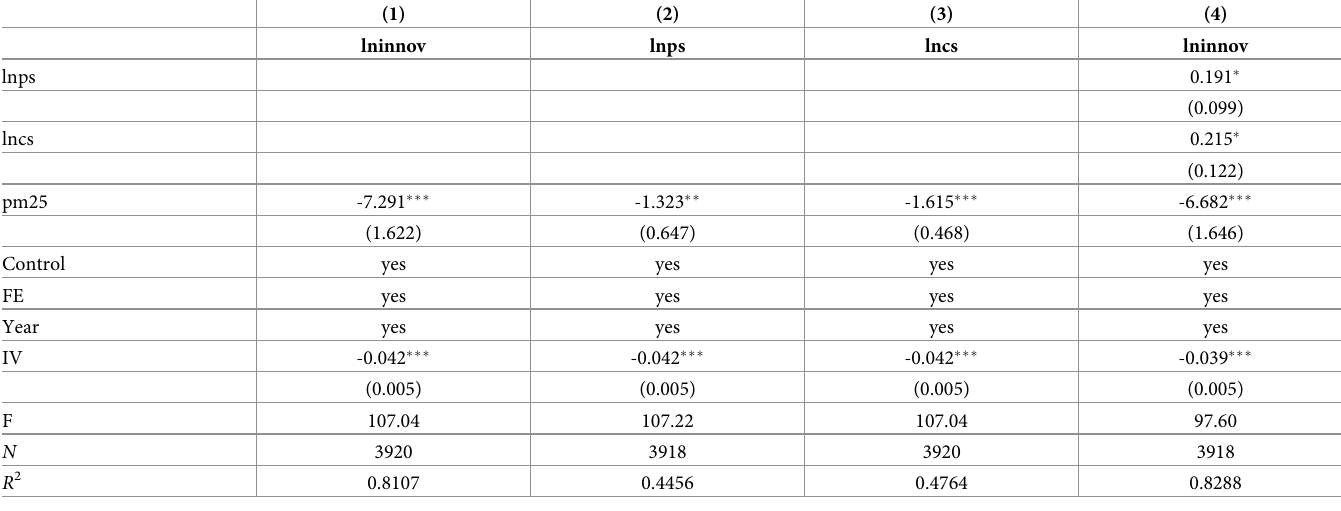
Table 10. Producer services and consumer